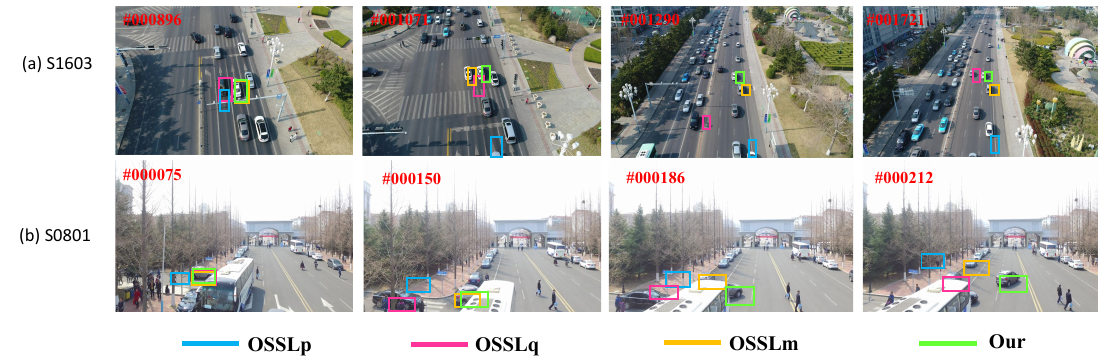
Figure 6. Distance precision and success rate of different functional parts on the UAVDT [7] dataset. Quantitative results on the 50 benchmark sequences using OPE [45]. The legend of distance precision contains threshold scores at 20 pixels, while the legend of overlapping success contains the area-under-the-curve score for each tracker.